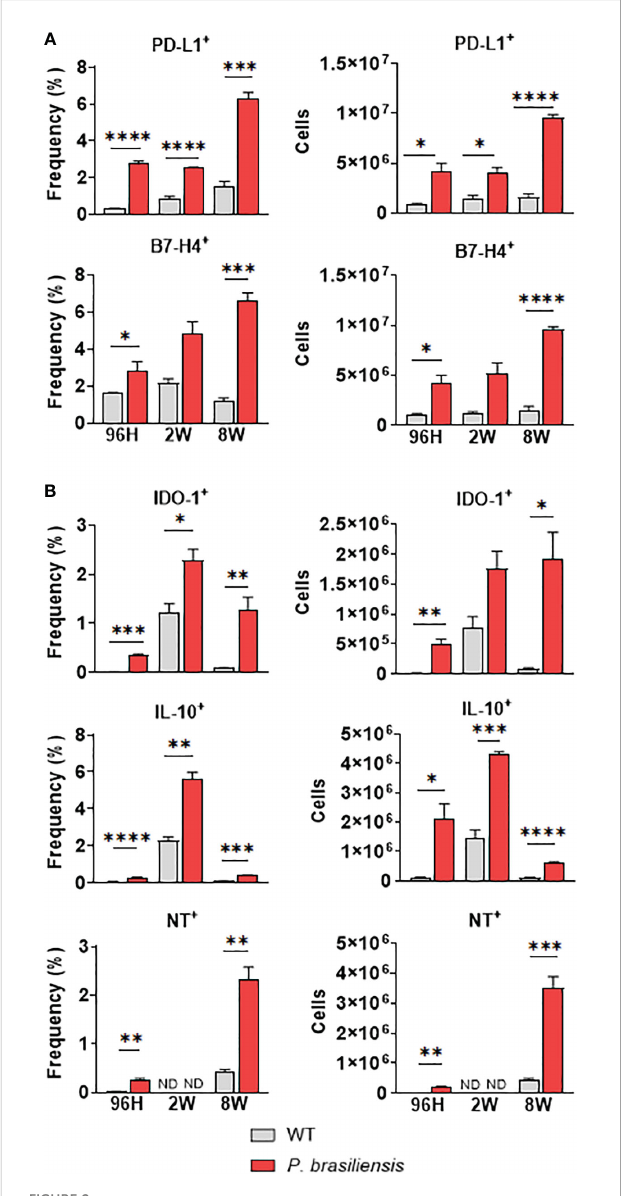
FIGURE 2 Immunosuppressive molecules expressed by polymorphonuclear-like MDSCs (PMN-MDSCs) in response to P. brasiliensis infection. The immunosuppressive molecules expressed by PMN-MDSCs were evaluated in the lung in fi ltrating cells of P. brasiliensis -infected mice (1×10 6 yeasts cells) by fl ow cytometric analysis with 96 hours, 2 weeks, and 8 weeks of infection. The expression of cell membrane molecules such as (A) CD274 (PD-L1) and B7-H4 as well as intracellular molecules (B) IDO-1, IL-10, and nitrotyrosine (NT) were evaluated in CD45 + CD11b + Ly6G + LY6C low cells (PMN-MDSC). Cells were gated by FSC/SSC analysis. Data represent three independent experiments with 3-4 mice each. For comparisons between two groups, the mean ± SEM was obtained and analyzed by the unpaired Student ’ s t -test. Differences were considered signi fi cant when: * p <0.05; ** p <0.01; *** p <0.001 and **** p